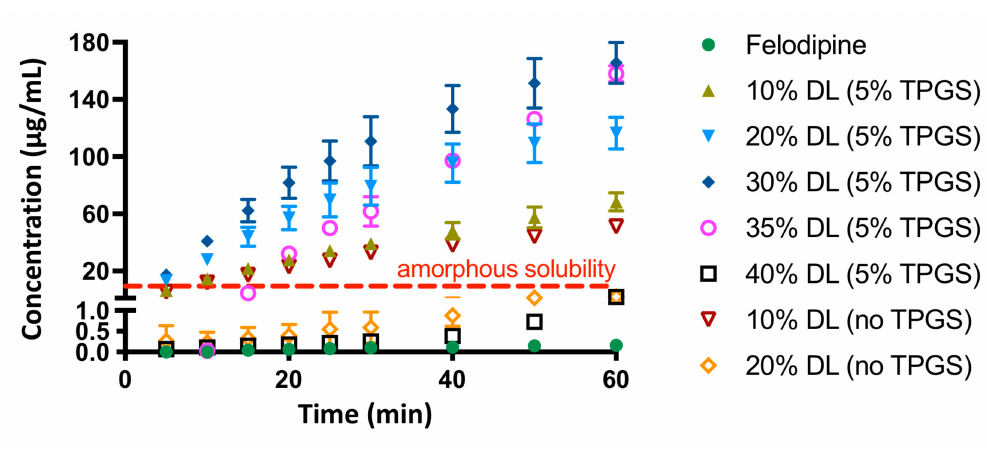
Figure 4. Concentration versus time profile for felodipine from amorphous drug alone, and as part of a PVPVA-based ASD with and without 5% TPGS. The legends represent drug loadings (by weight) and TPGS% in the ASDs. Error bars represent standard deviations, n = 3, and may be smaller than symbols in some